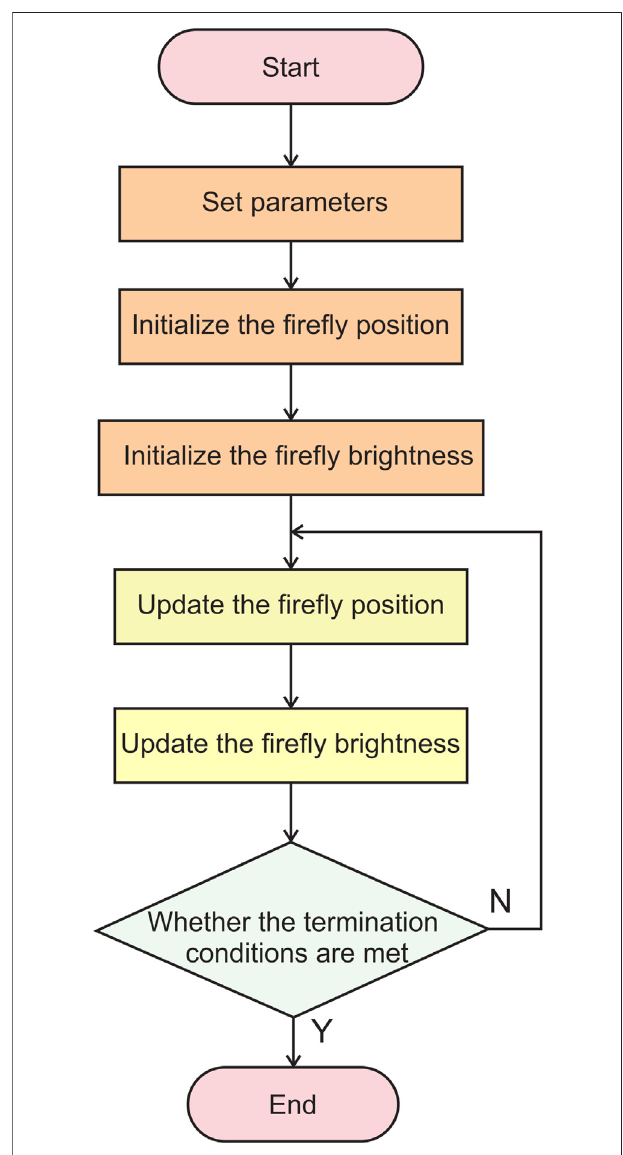
FIGURE 4 | Flow chart of the fi re fl y